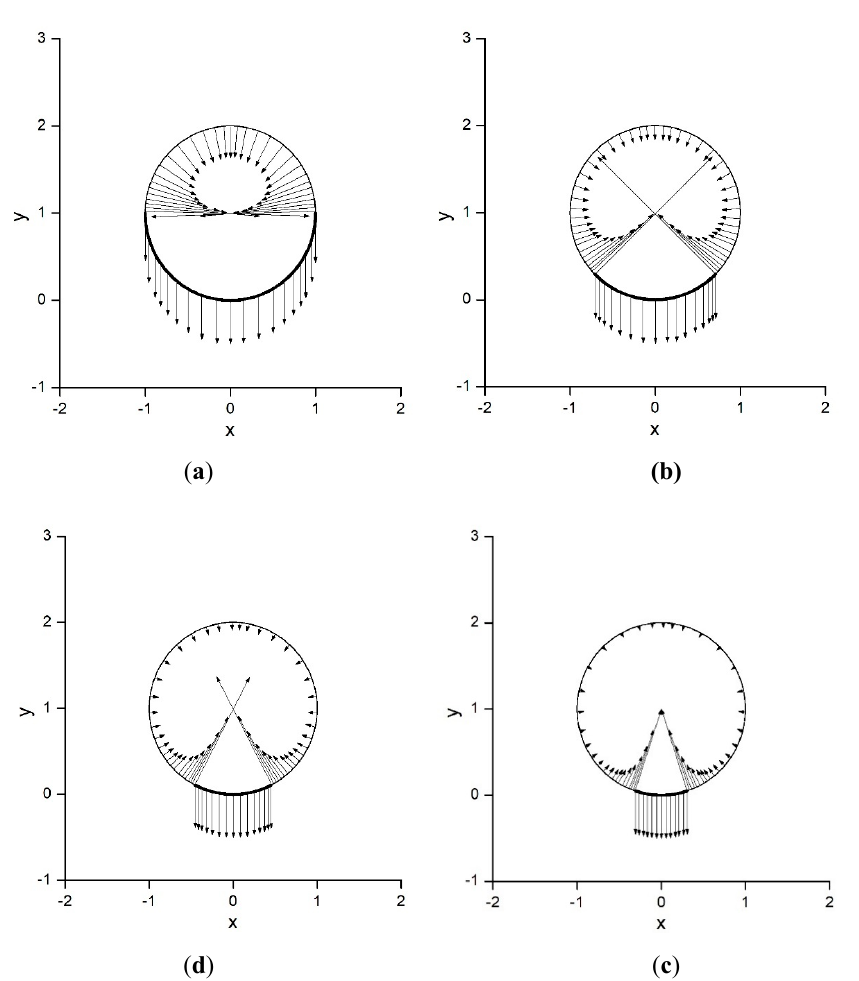
Figure 4. Velocity distribution along the cross section of the cylindrical cavity for different angles of the arc: ( a ) ϕ = 0.5 π ; ( b ) ϕ = 0.25 π ; ( c ) ϕ = 0.15 π , and ( d ) ϕ = 0.1 π